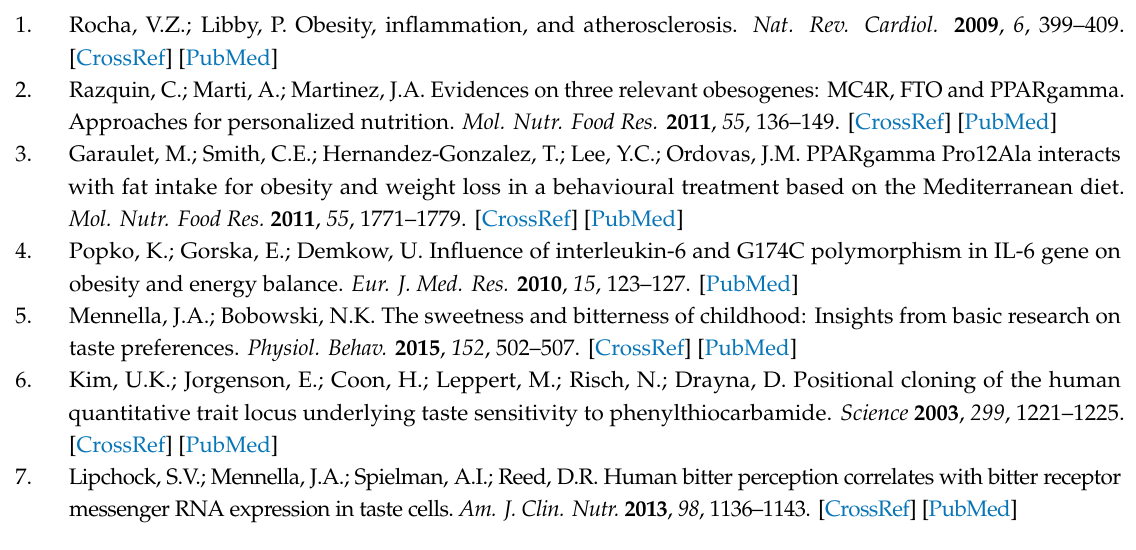
Table S1: The food groups analyzed in the current